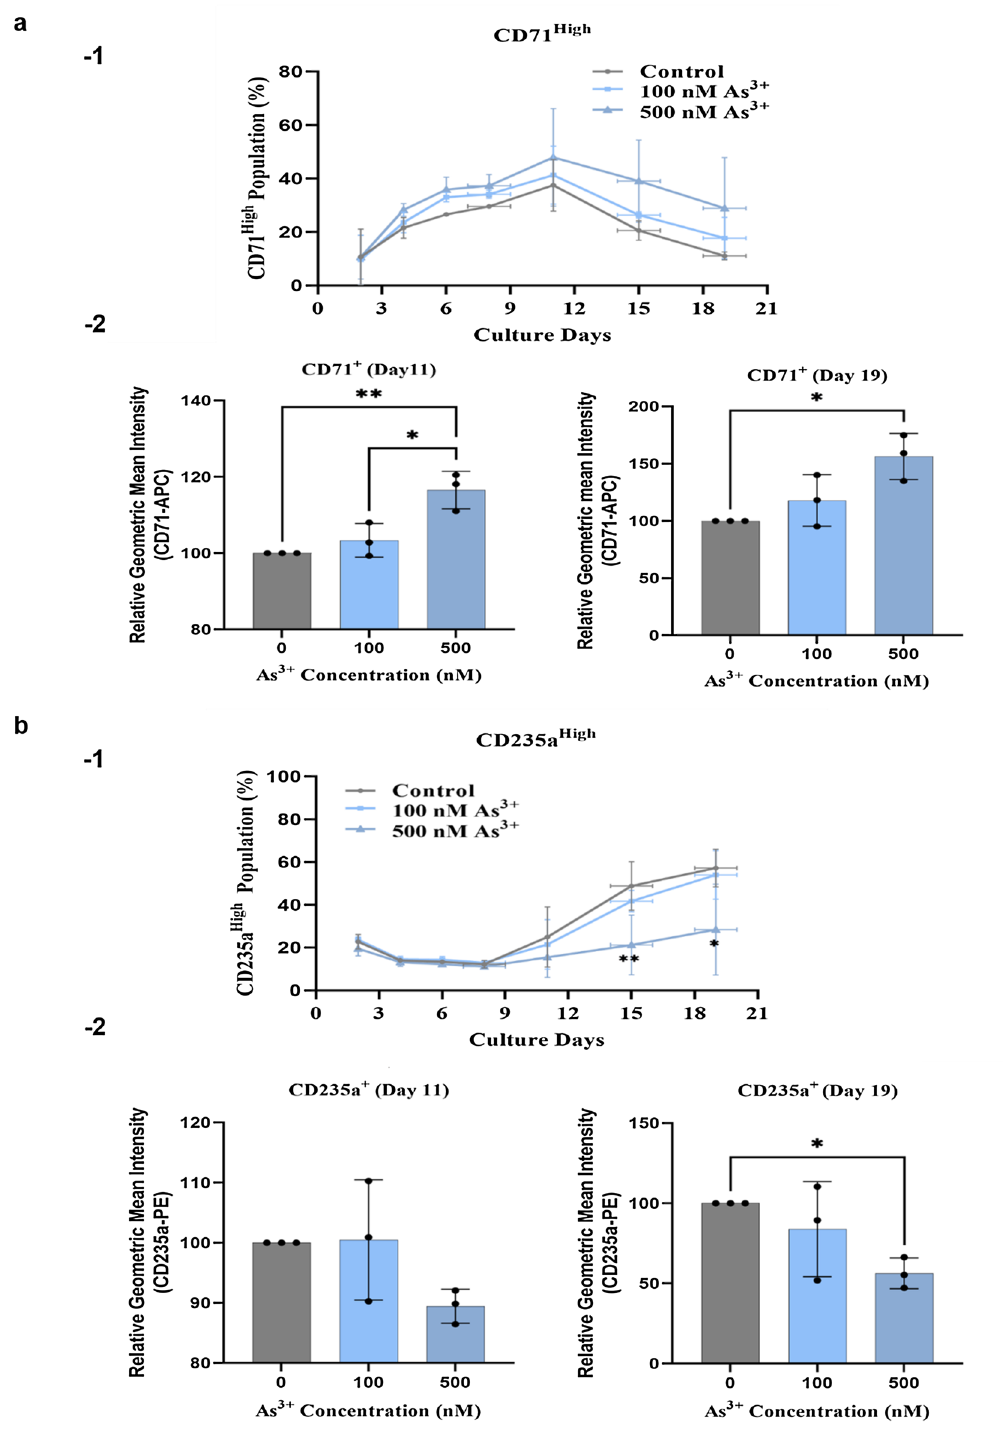
Figure 3. As 3+ exposure increases CD71 signal, but decreases CD235a expression during erythroid expansion of CD34 + cells. Human bone marrow CD34 + -HPCs (1 × 10 4 cells/ml) were cultured for 2–19 (± 1) days in erythroid expansion medium with the addition of 0, or 100 nM or 500 nM As 3+ . At the time points (days 2, 4, 6, 8/9, 11, 15/16, and 19 ± 1), cells were stained with APC-conjugated antibody against CD71 (CD71-APC), and PE-conjugated antibody against CD235a (CD235a-PE) and analyzed by flow cytometry. The definitions of each cell population, including CD71 + , CD71 High , CD235a + , and CD235a High , are indicated in Supplementary Figs. S1 and S4. ( a-1 ) As 3+ exposure increases CD71 High populations throughout the time course investigated. ( a-2 ) As 3+ exposure at 500 nM significantly increases the mean fluorescence intensity of CD71 + cells on days 11 and 19 (± 1). ( b-1 ) As 3+ exposure (500 nM) decreases CD235a signal. ( b-2 ) As 3+ exposure (500 nM) significantly decreases mean fluorescence intensity of CD235a + cells on day 11 and 19 (± 1). Data are expressed as summarized mean ± SD from three donors, n = 3 replicates/donor/group, *( p < 0.05), and **( p < 0.01) in one-way ANOVA, followed by Tukey’s post hoc test between the